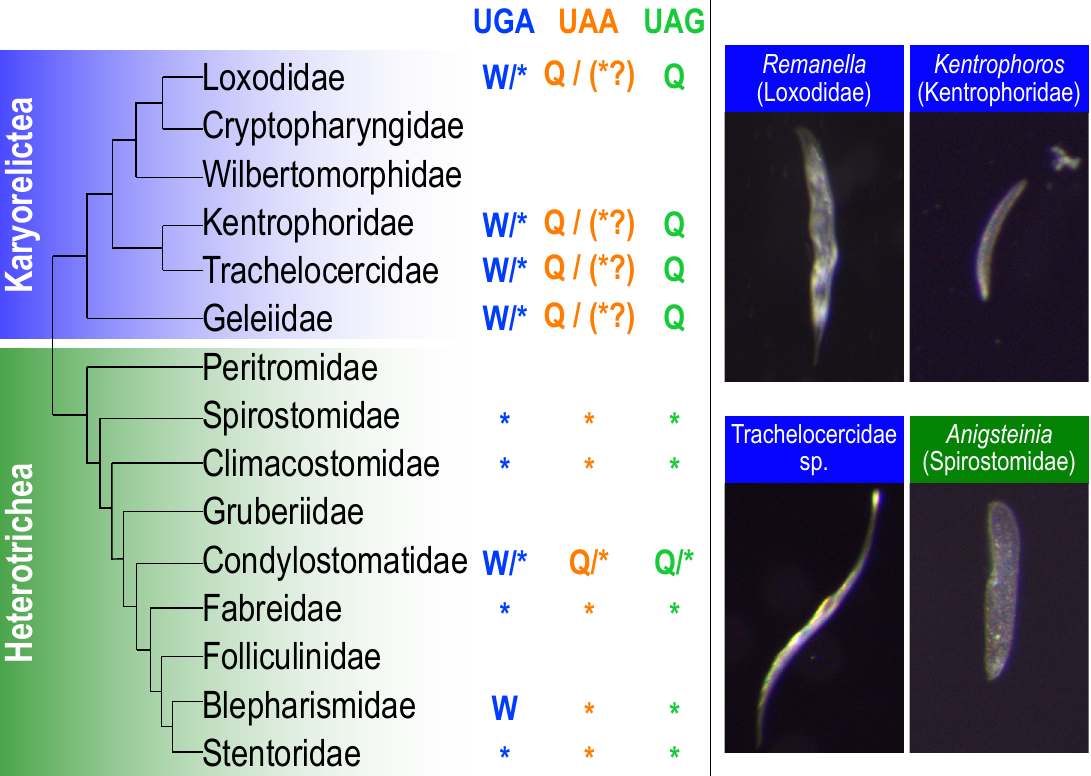
Figure 6 . Genetic code diversity among karyorelict and heterotrich ciliates. ( Left ) Diagrammatic karyorelict + heterotrich tree with predicted stop codon reassignments mapped to each family. Subtree topologies are from refs. [20] and [25] respectively. Branch lengths are not representative of evolutionary distances. ( Right ) Photomicrographs of ciliates (incident light) collected in this study from Roscoff, France; height of each panel 50